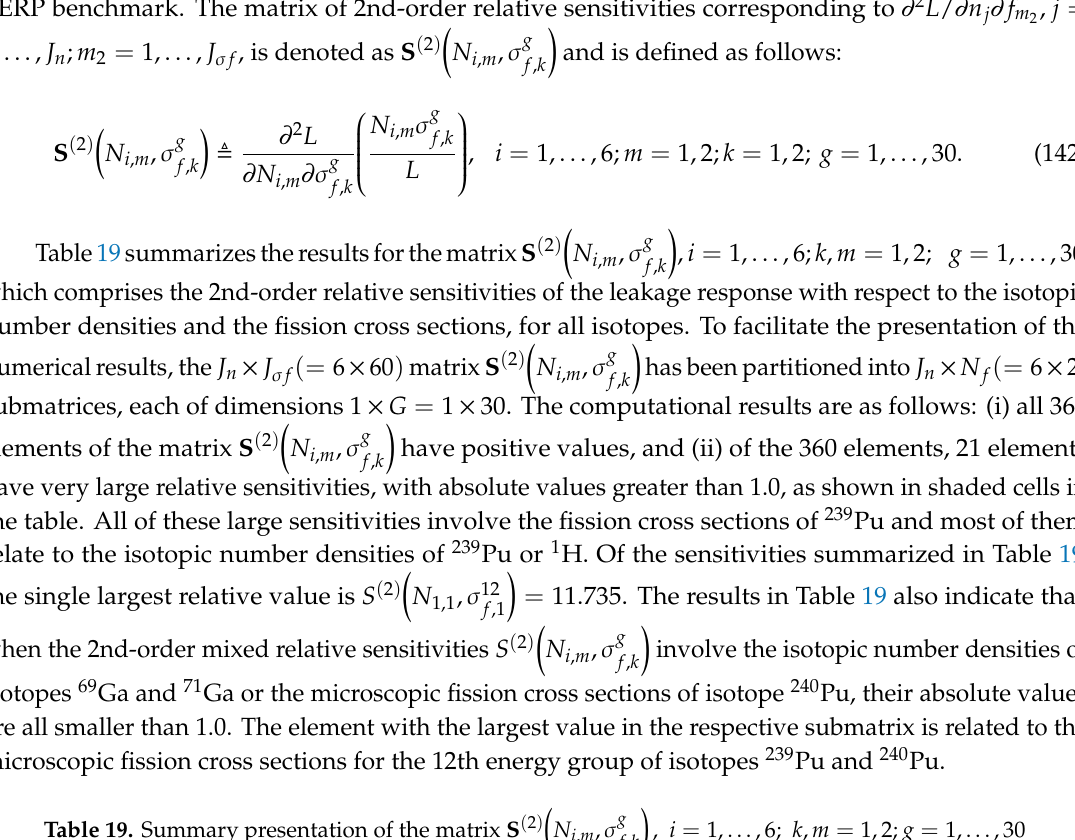
Table 19. Summary presentation of the matrix S ( 2 )